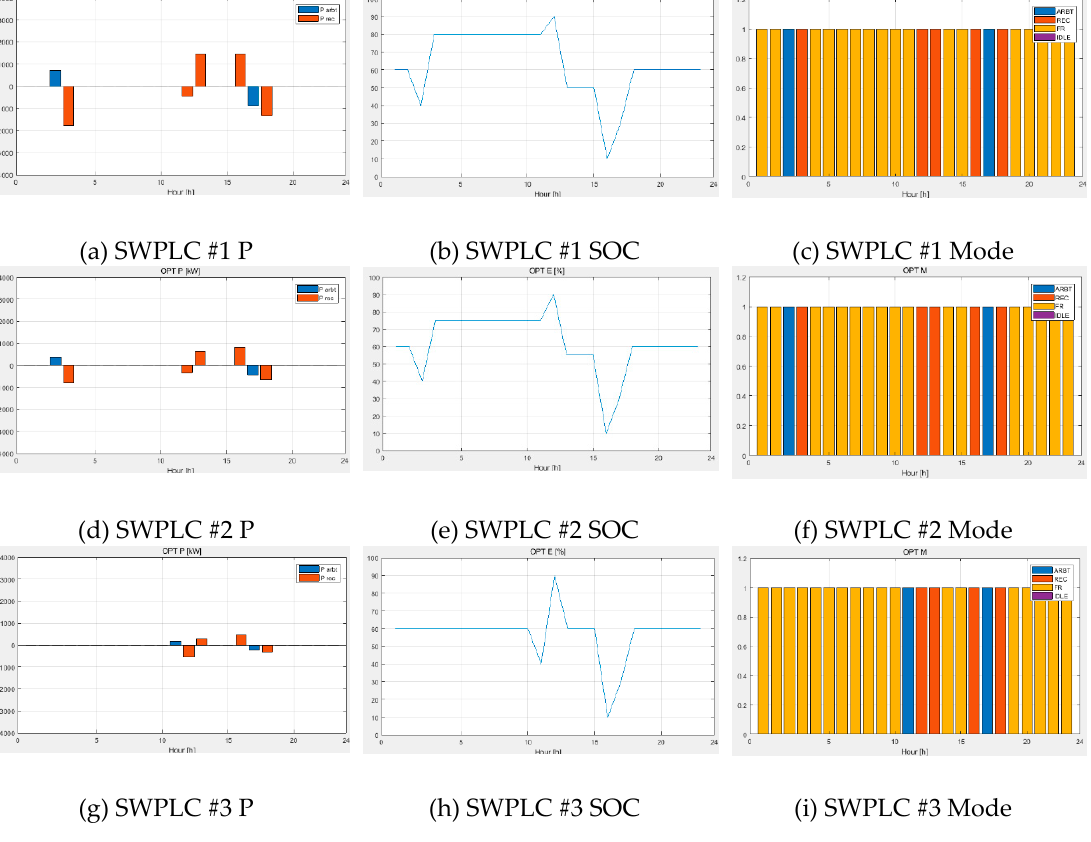
Figure 3. Scenario 1 simulation results.